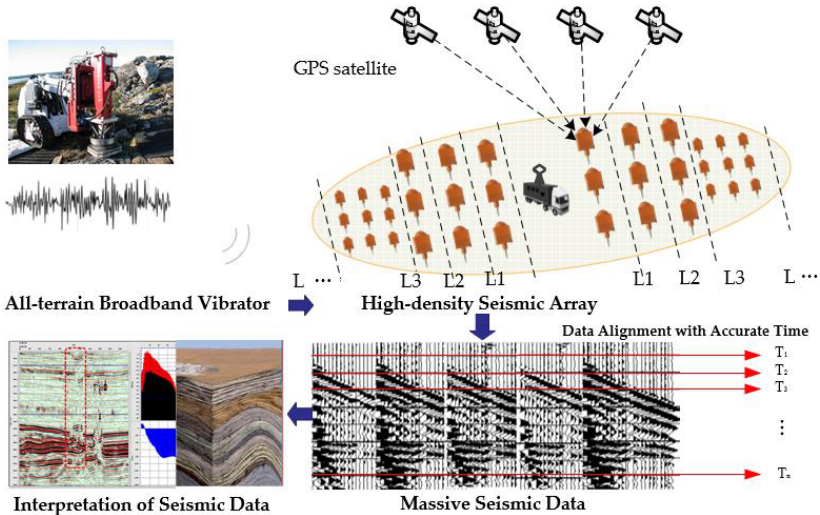
Figure 1. Schematic diagram for time synchronization in the high-density seismic array survey.